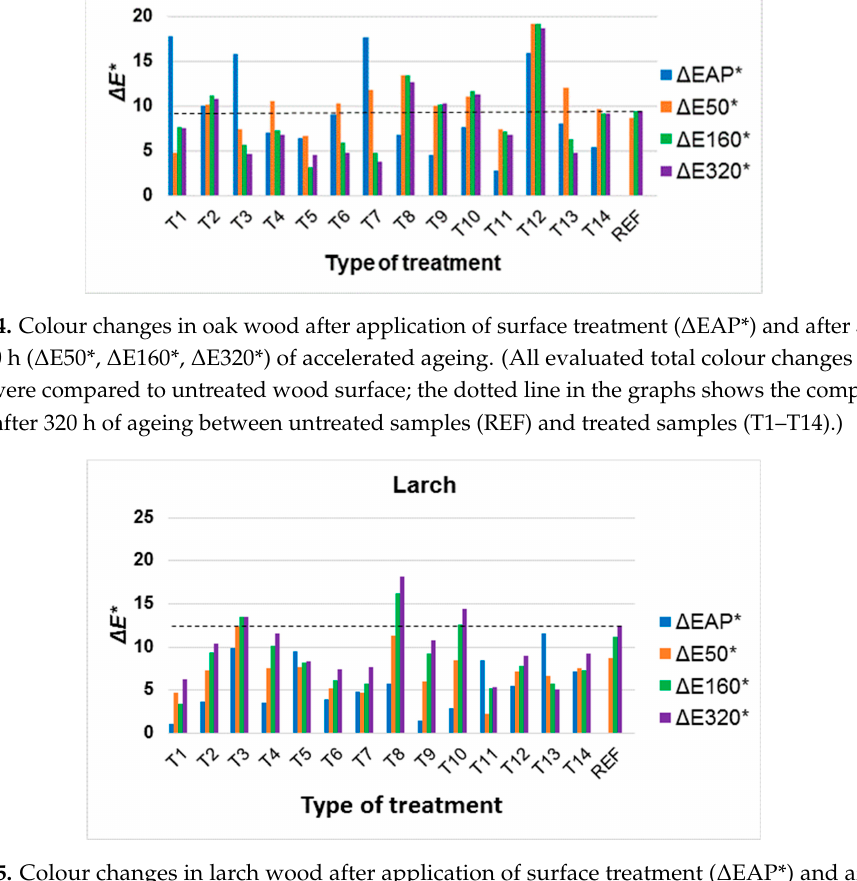
Figure 5. Colour changes in larch wood after application of surface treatment ( Δ EAP*) and after 50, 160 and 320 h ( Δ E50*, Δ E160*, Δ E320*) of accelerated ageing. (All evaluated total colour changes Δ E* in graph were compared to untreated wood surface.)